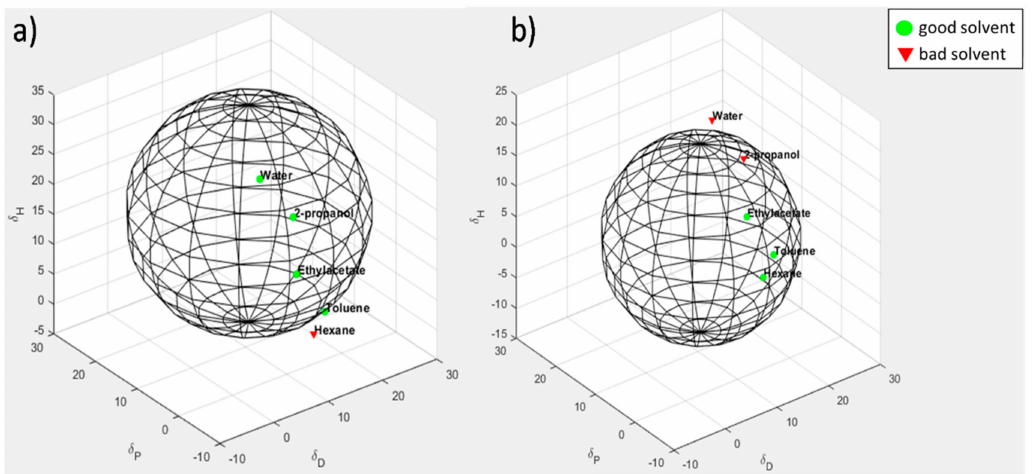
Figure 8. Hansen solubility sphere calculated for ( a ) CNT-SP and ( b ) CNT-DDcP. HSP (MPa1 / 2): for CNT-SP: δ D 12.0, δ P 11.8, δ H 15.7; for CNT-DDcP: δ D 8.5, δ P 7.5, δ H 5.3. The green circles correspond to the good solvents (within the radius of interaction); the red triangles correspond to the bad solvents (outside the